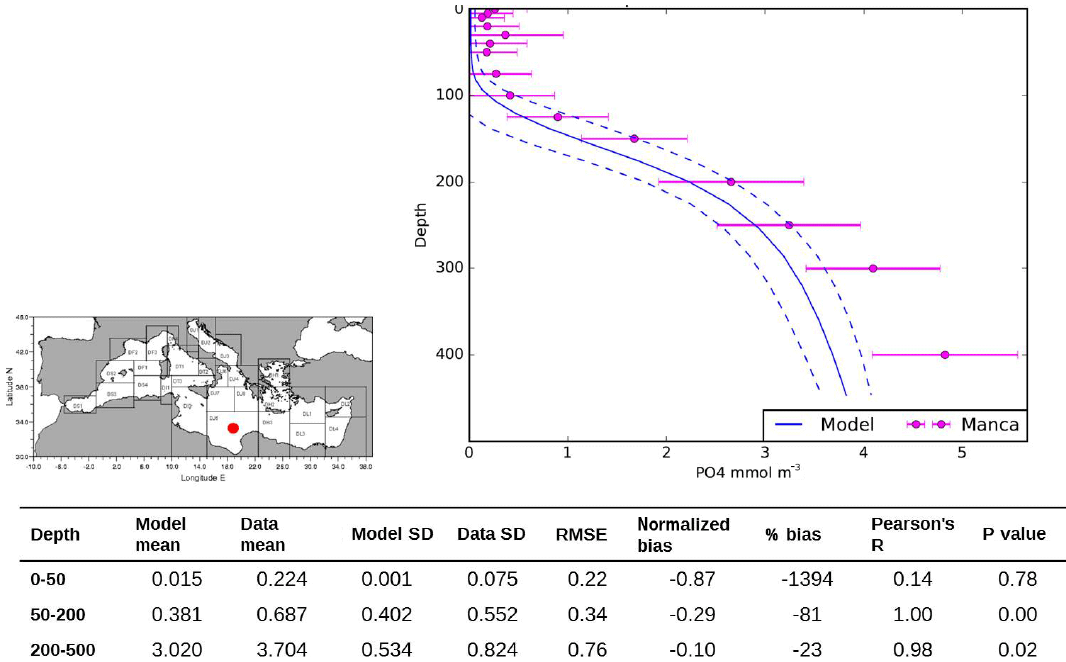
Figure A8. Annually averaged NO 3 vertical profile in the south Ionian sub-basin (see map and Manca et al., 2004) and statistical indicators over different depths. Model values are shown with the blue line (2005 average, Ntot simulation from Richon et al., 2017) and measured values from Manca et al. (2004) are in pink. Horizontal bars and dashed lines indicate the spatial SD of observations and model results